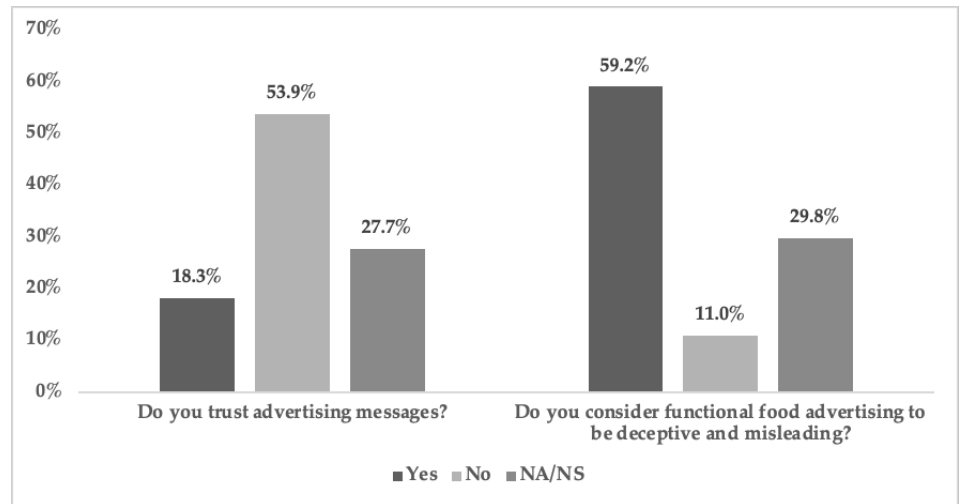
Figure 2. Degree of trust in food advertising messages and degree of misleading. A univariate descriptive analysis is conducted to observe the frequency distribution. (NS = Not Sure / NA = No Answer).